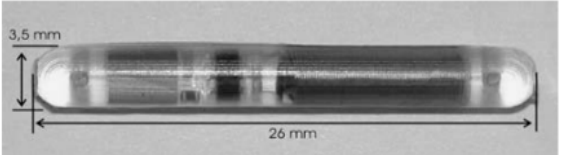
Figure 3. An abdominal aortic aneurysm (AAA) pressure sensor (Helmholtz Institute for Biomedical Engineering & Institute of Materials in Electrical Engineering, RWTH Aachen).